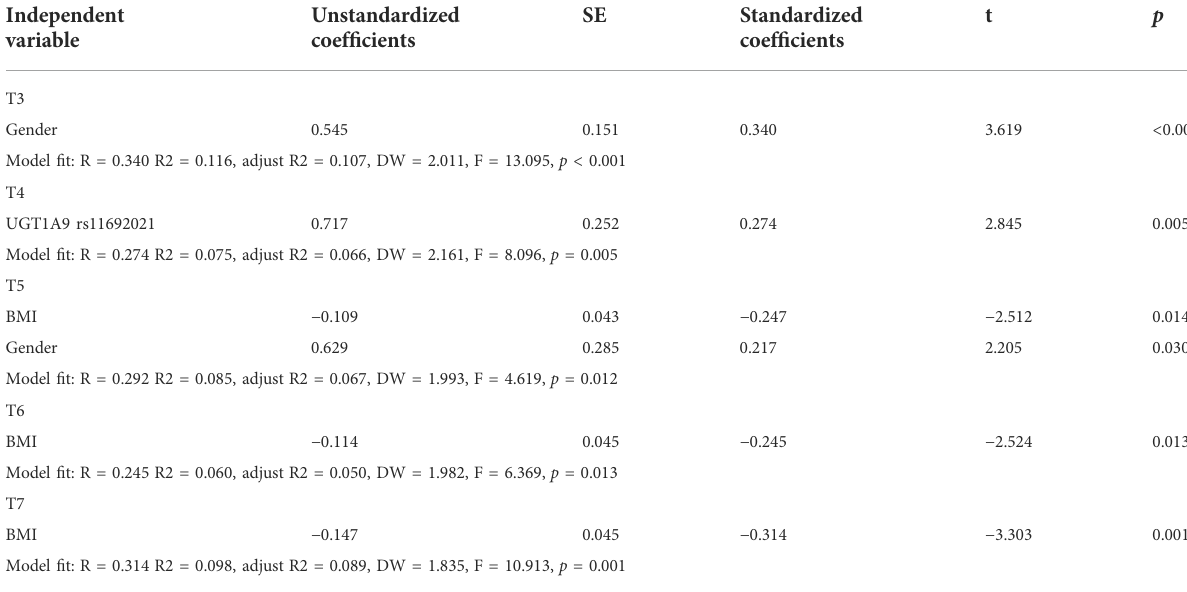
TABLE 4 Multiple linear regression analysis of clinical variables related to EOAA/S score.